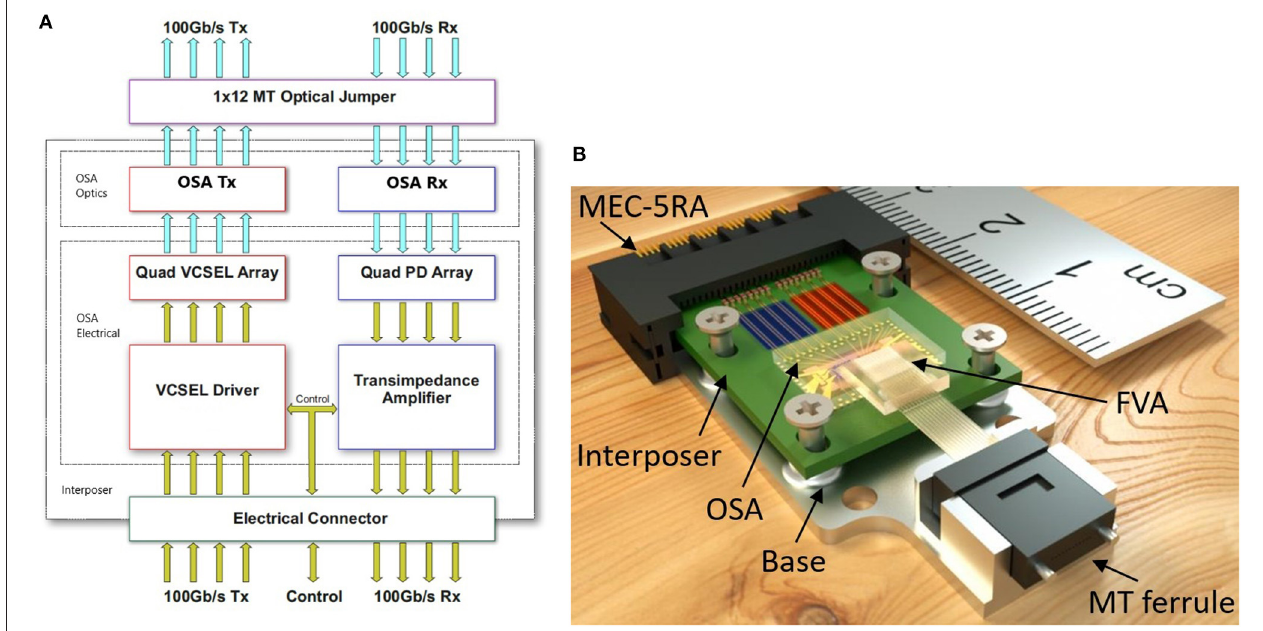
FIGURE 3 | (A) Functional diagram and (B) CAD rendering of the mid-board optical transceiver module [9].